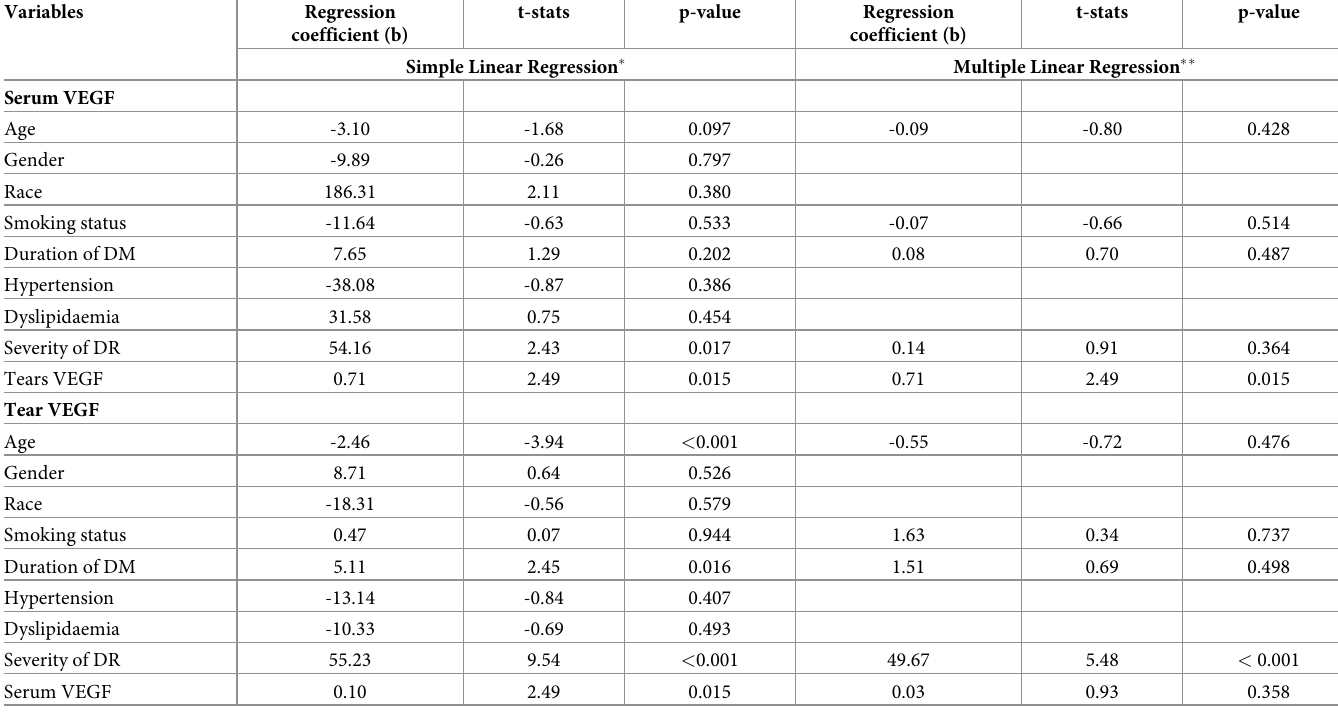
between serum and tear VEGF levels ( p = 0.015, r = 0.263). Table 4. Associated factors of serum and tears